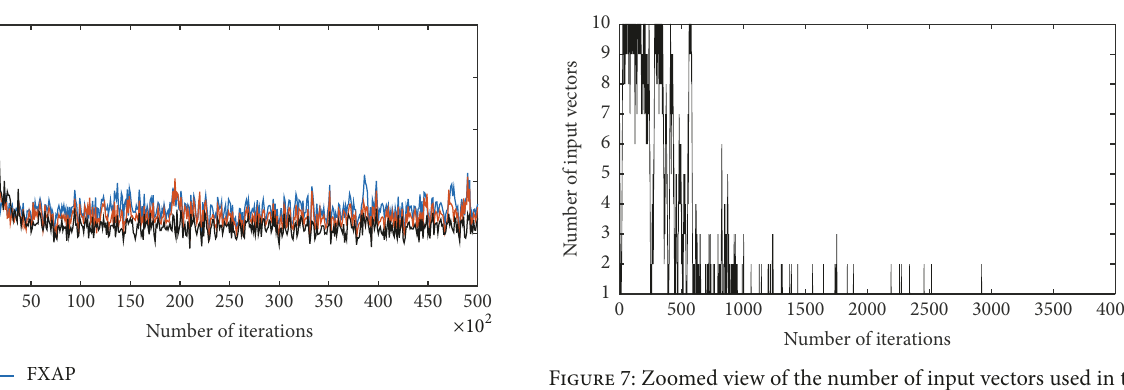
Figure 7: Zoomed view of the number of input vectors used in the proposed FXECAP-L algorithm when 𝐿 = 10 and 𝑏 = 2